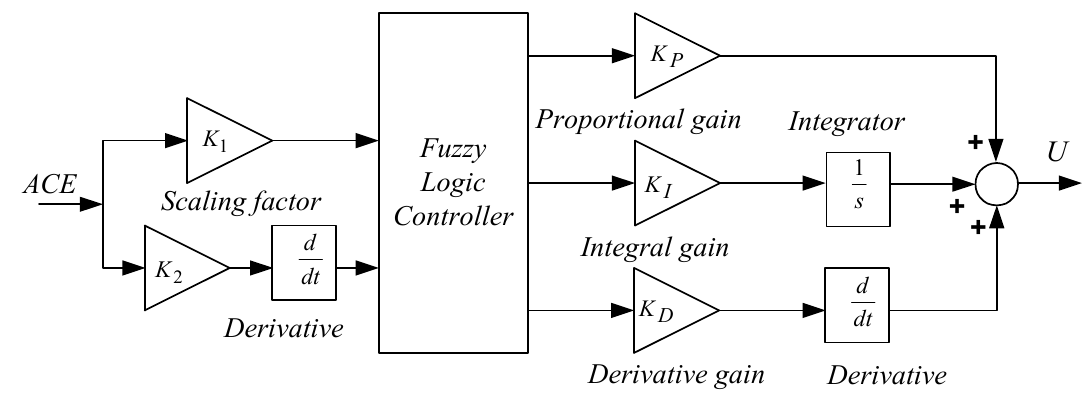
Figure 2. Structure of fuzzy PID controller.